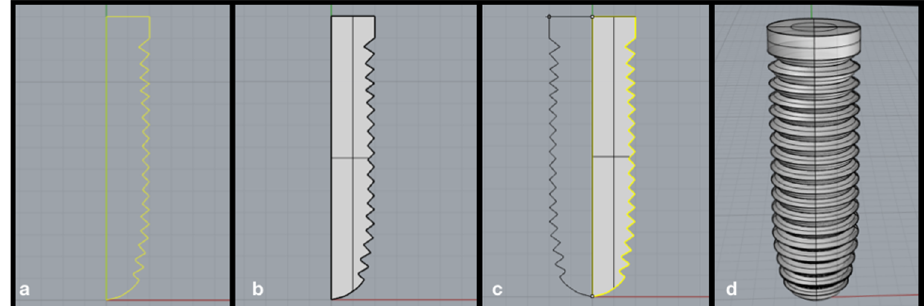
Figure 2. Steps to create the 3D symmetric model. Legend: ( a ) selection of lines; ( b ) surface created between the lines; ( c ) selection of the revolve command ( full circle ) on the “y” axis; ( d ) 3D volumetric model of the implant.